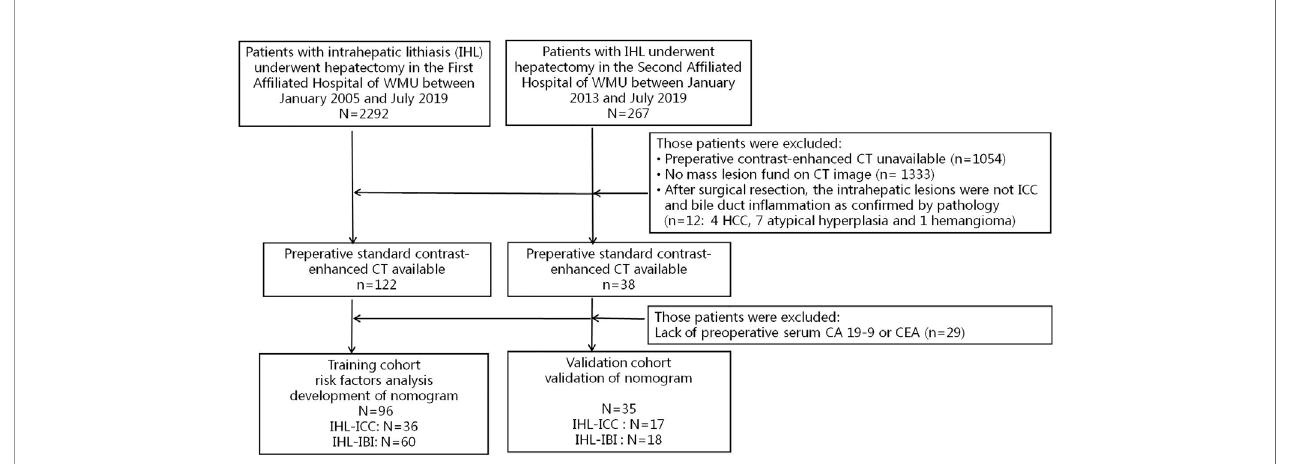
FIGURE 1 | Proceeding fl ow of